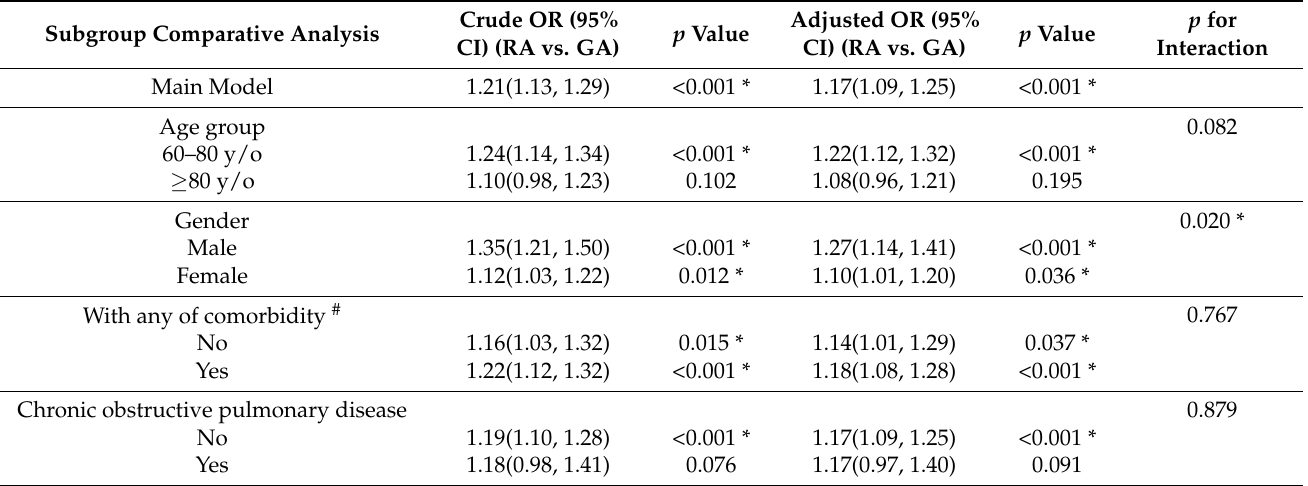
Table 3. Subgroup comparative analysis of different age, gender, with or without any comorbidity, and with or without chronic obstructive pulmonary disease group associated with the incidence of acute respiratory infection within postoperative 1 month ( n =